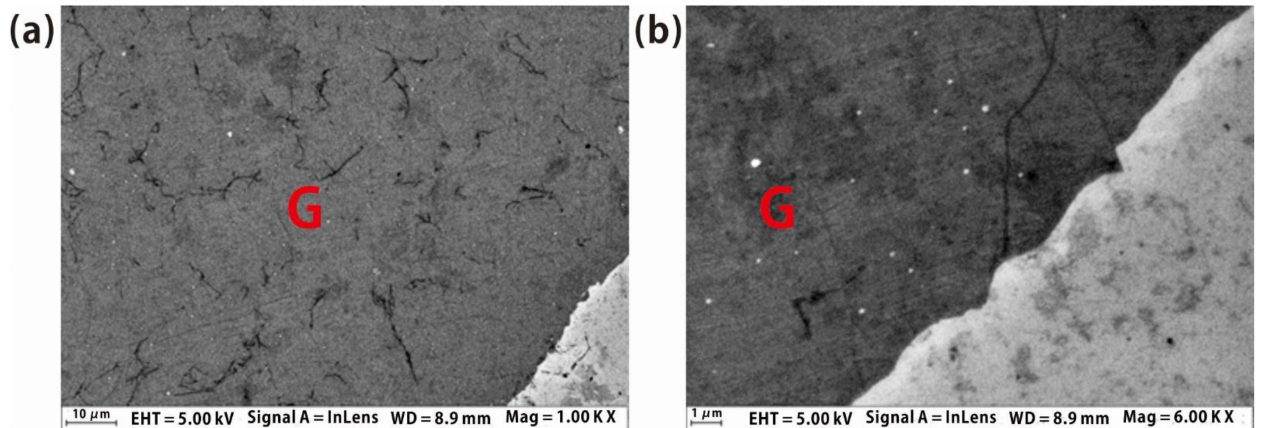
Figure 2. ( a ) SEM image of graphene prepared by liquid benzene at high temperature of 1060 ◦ C with benzene partial pressure of 1.1 Pa. G refers to the parts covered by graphene; ( b ) enlarged SEM image of the graphene surface.